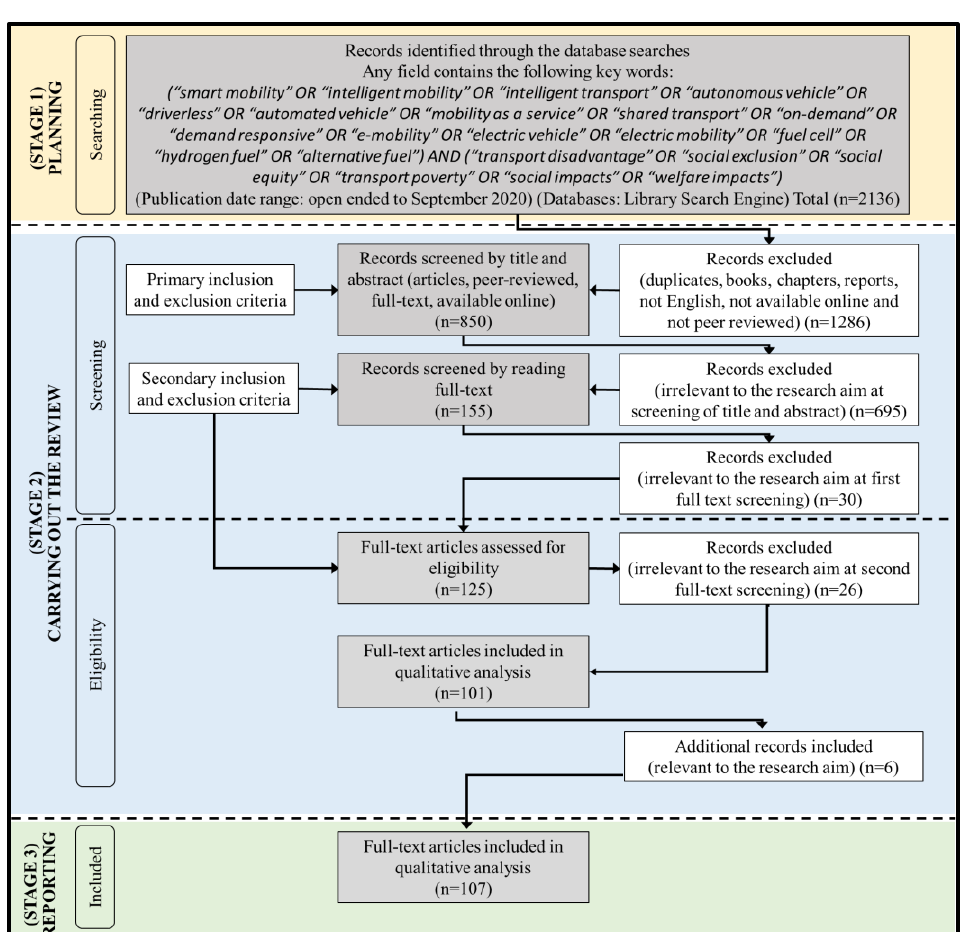
Figure 2. Literature selection procedure (source: authors).